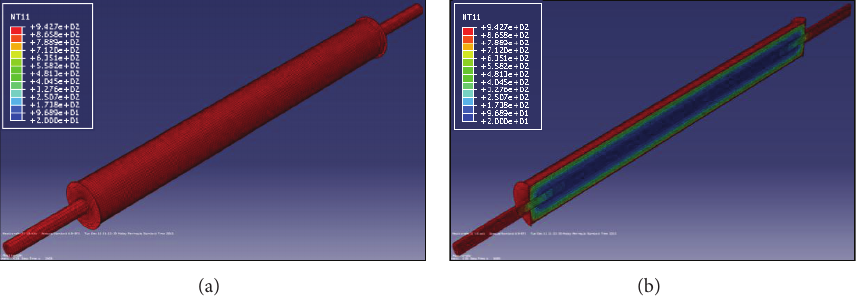
Figure 3: (a) Heat transfer from the fire to the exposed surface of BRB by convection and radiation, (b) heat distribution from the exterior surface of BRB to the inner surfaces.